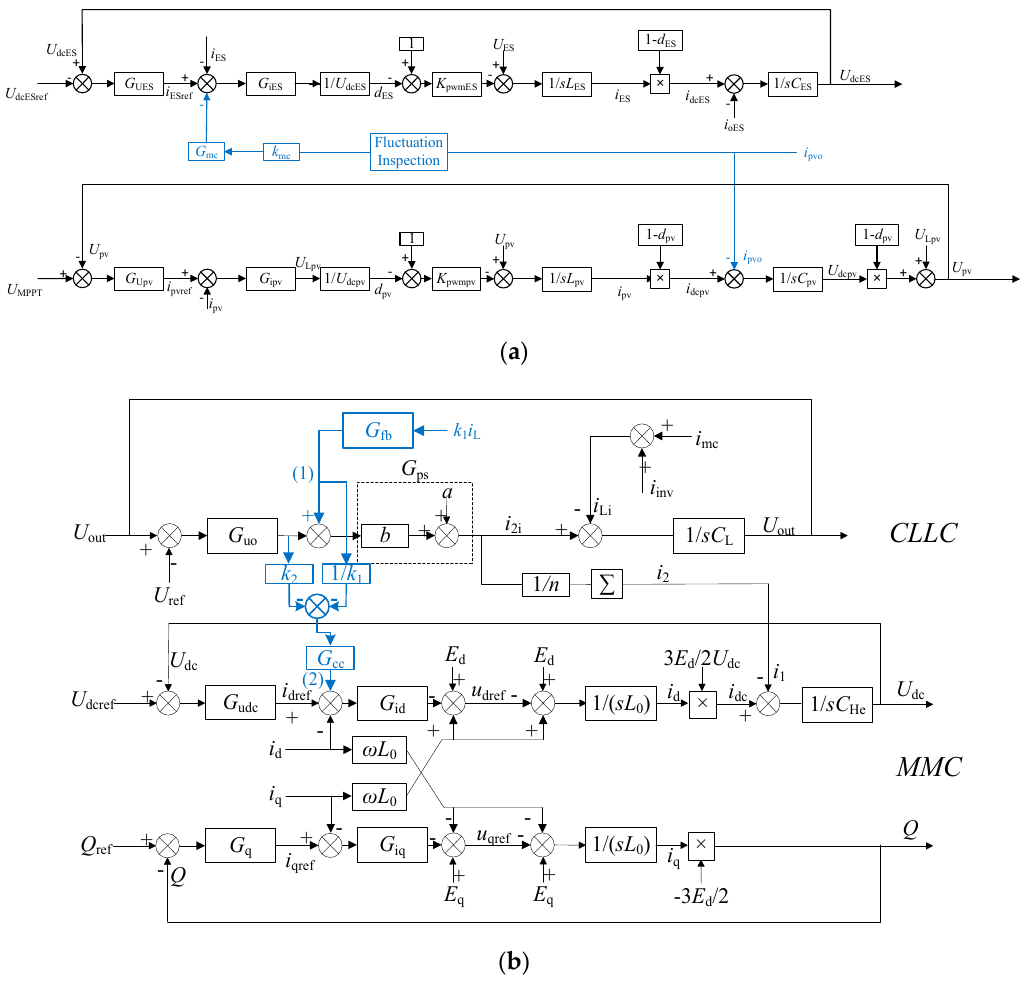
Figure 9. The hierarchical coordinative control diagram: ( a ) the microgrid layer control; ( b ) the SST layer